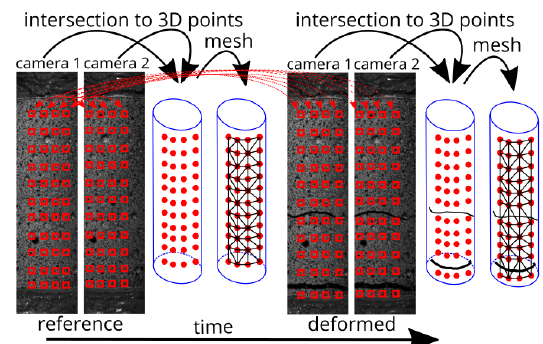
Figure 10. Principle of the displacement field determination and triangulation, based on (Liebold et al.,